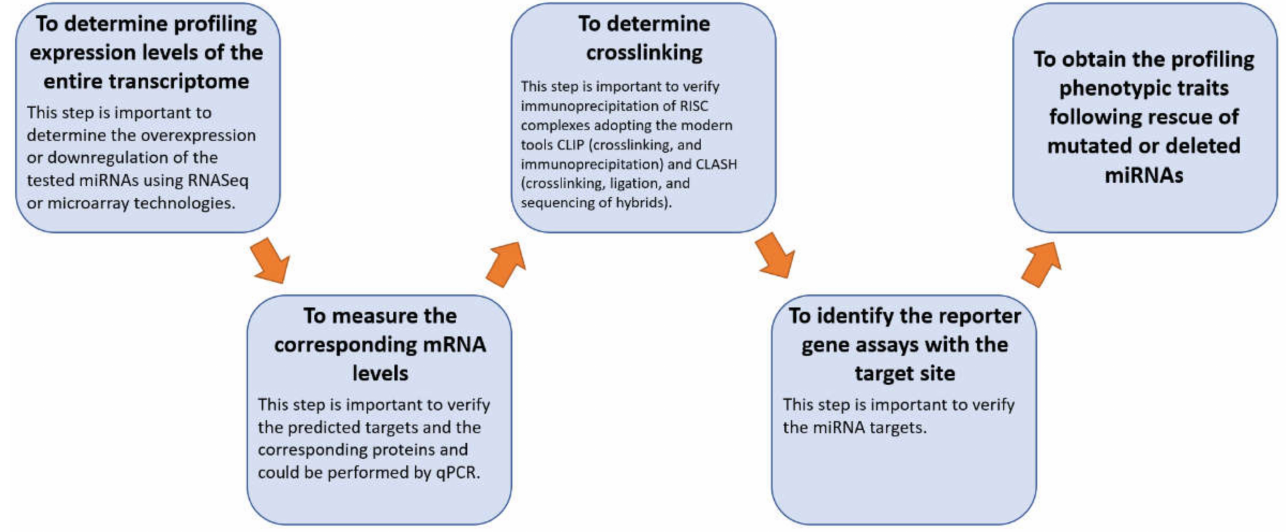
Figure 1. Diagram of the experimental protocols that could be applied to perform an in vivo